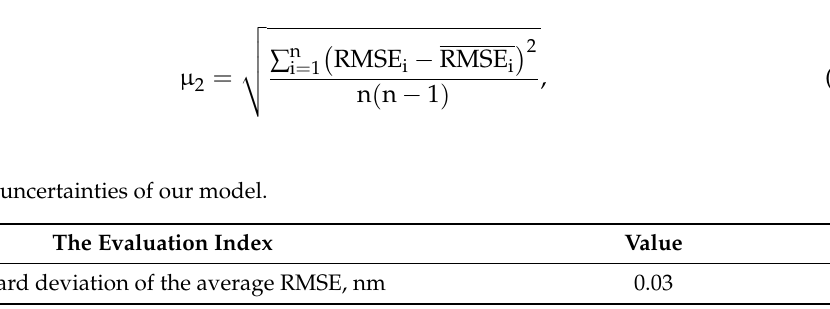
Figure 13. The MSE and RMAE of Focus & TSOM-CNN in multiple tests. ( a ) MSE and ( b ) RMAE. The standard deviation of the mean of RMSE (Equation (6)) is normally used to evaluate uncertainties of the model. The result of model uncertainties is shown in Table 2.